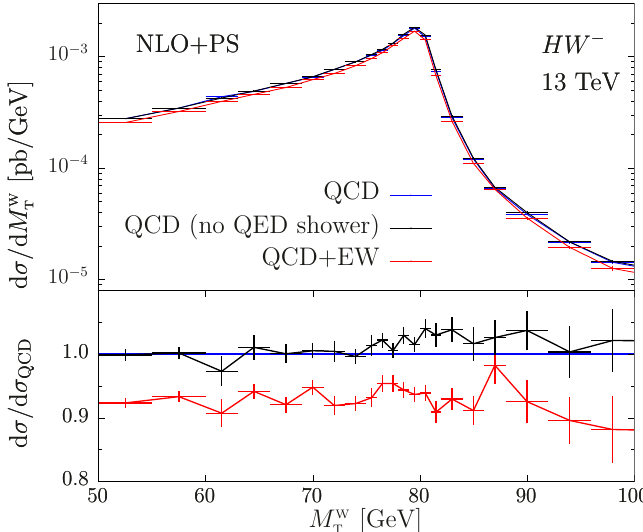
Figure 13. NLO+PS predictions for the transverse mass of the reconstructed W (cid:0) boson in HW (cid:0) production. Same curves and labels as in (cid:12)gure 12. To illustrate the e(cid:11)ect of the QED shower, we also show results obtained by showering QCD-corrected events with the QED shower switched o(cid:11) in Pythia 8.1 (\no QED shower").